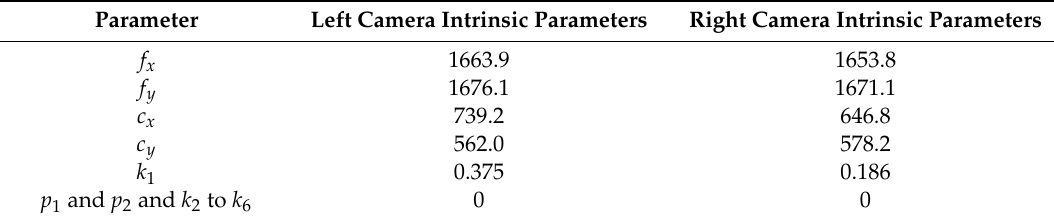
Table 2. Intrinsic parameters of the cameras in the 1-story brick-walled RC experiment. Parameter